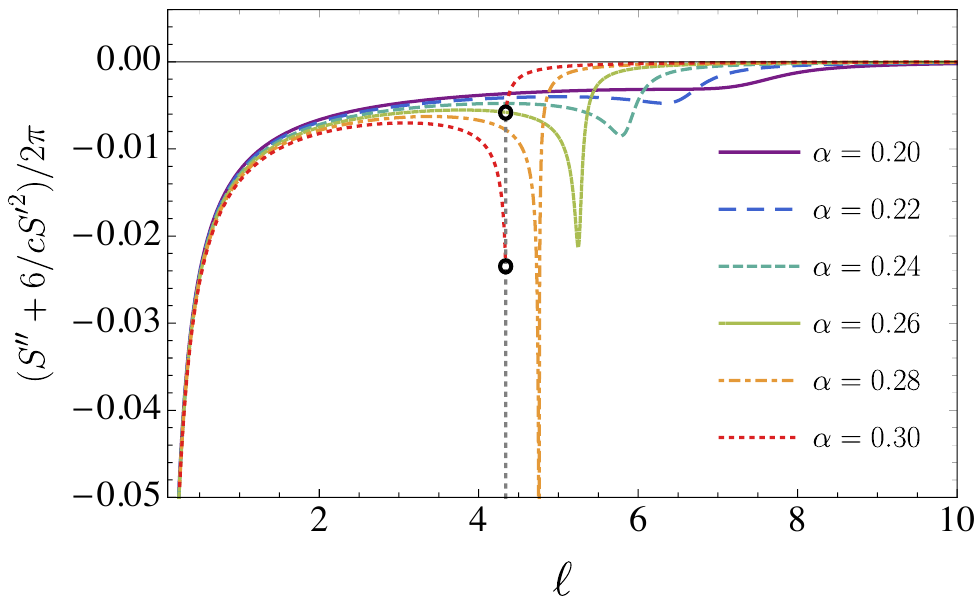
Figure 13 . Ground state QNEC 2 as function of ‘ for 0 . 2 ≤ α ≤ 0 . 3